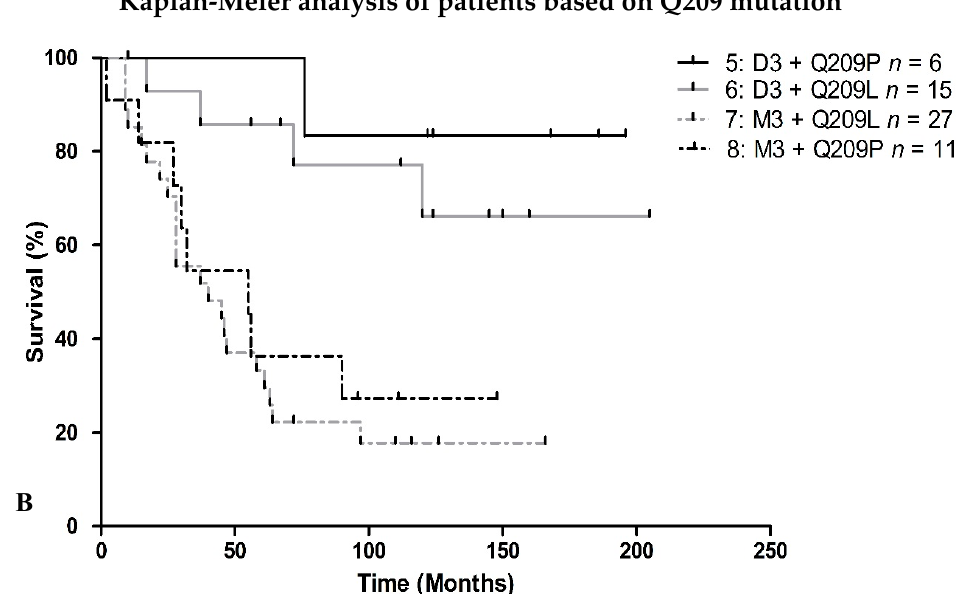
Figure 2. Survival of 59 UM patients, split depending on the location of the mutation ( A ) or type of mutation ( B ). p -values for the differences between the groups calculated with the log-rank function were ( A ): 1 versus 2 : p = 0.47, 1 versus 3 : p < 0.001, 2 versus 4 : p = 0.030, 3 versus 4 : p = 0.90; ( B ): 5 versus 6 : p = 0.77, 6 versus 7 : p = 0.002, 5 versus 7 : p = 0.007, 7 versus 8 : p = 0.07.